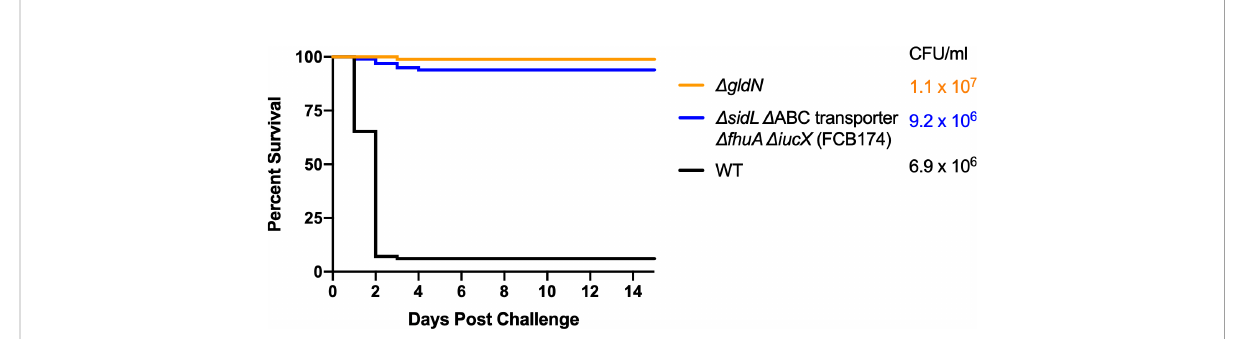
FIGURE 9 Virulence of F. columnare wild type and iron mutants toward rainbow trout alevin. Rainbow trout were exposed to the wild type (black), D gldN (orange), and D sidL D ABC transporter D fhuA D iucX (FCB174) (blue) mutants. The fi nal challenge concentrations for each strain are shown in the corresponding color. Signi fi cant differences in the percent survival for fi sh challenged were seen between the WT and FCB174 (P < 0.0001).